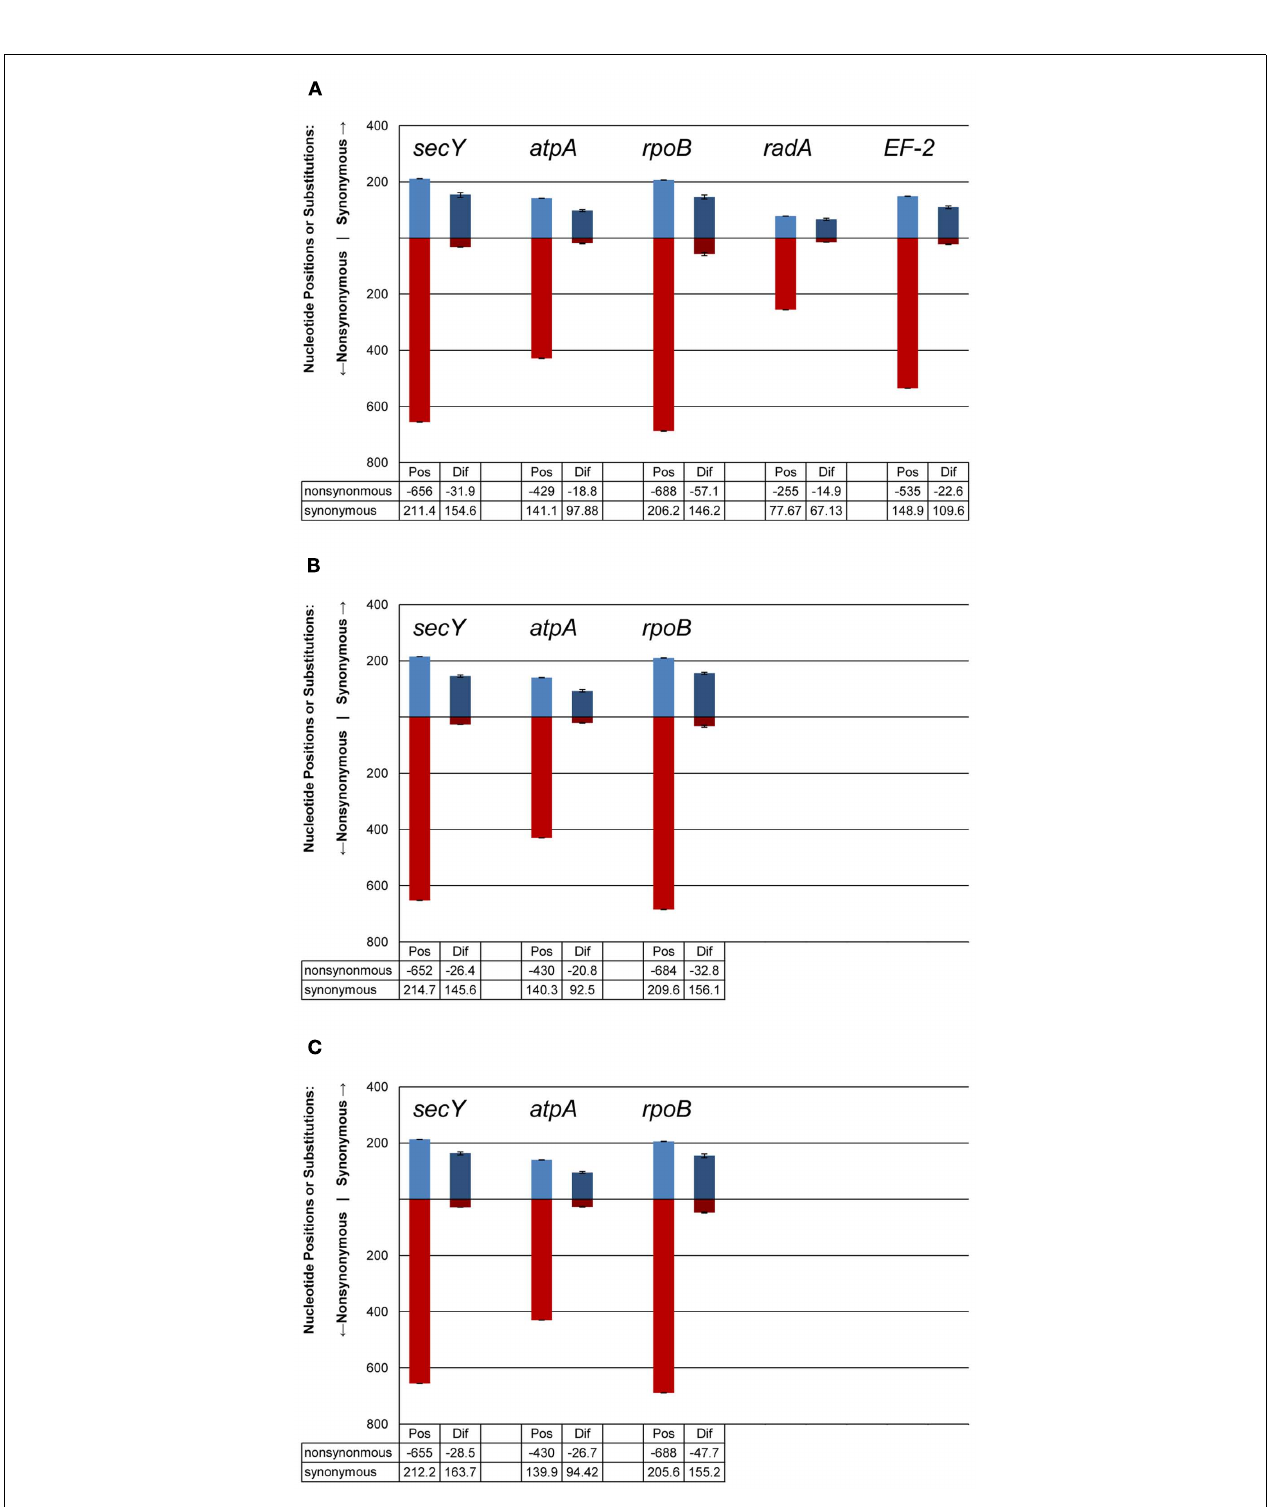
FIGURE 7 | Synonymous and non-synonymous nucleotide positions and substitutions in protein-coding loci among DHVE2 isolates from different regions. (A) Isolates from the MAR compared to isolates from the ELSC (B) isolates from the ELSC compared to isolates from the East Pacific Rise; (C)